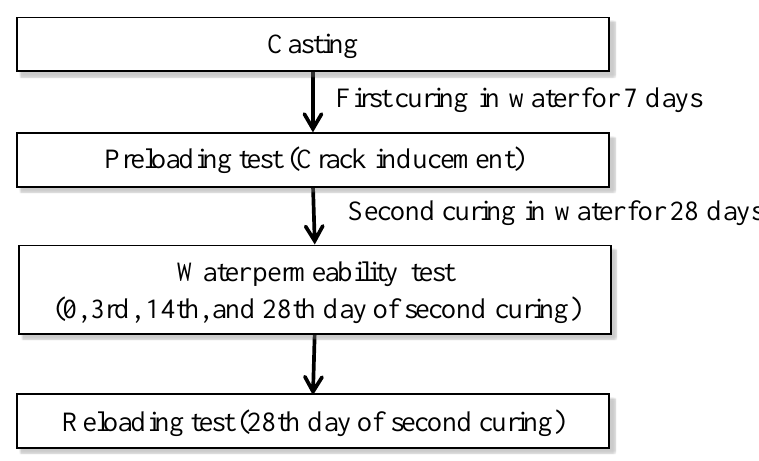
Figure 4. Experimental procedure.